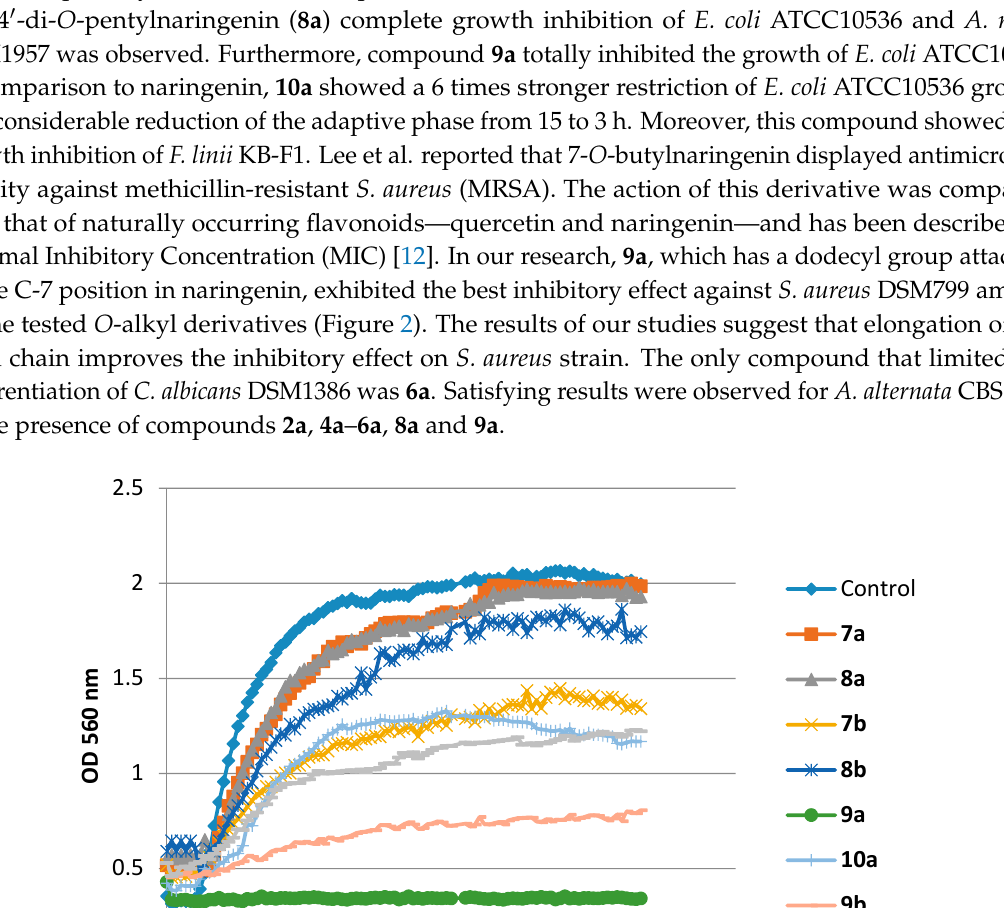
Figure 3. The effect of action of O -alkyl derivatives of naringenin ( 7a – 10a ) and their oximes ( 7b – 10b ) on the growth of F. linii KB-F1.